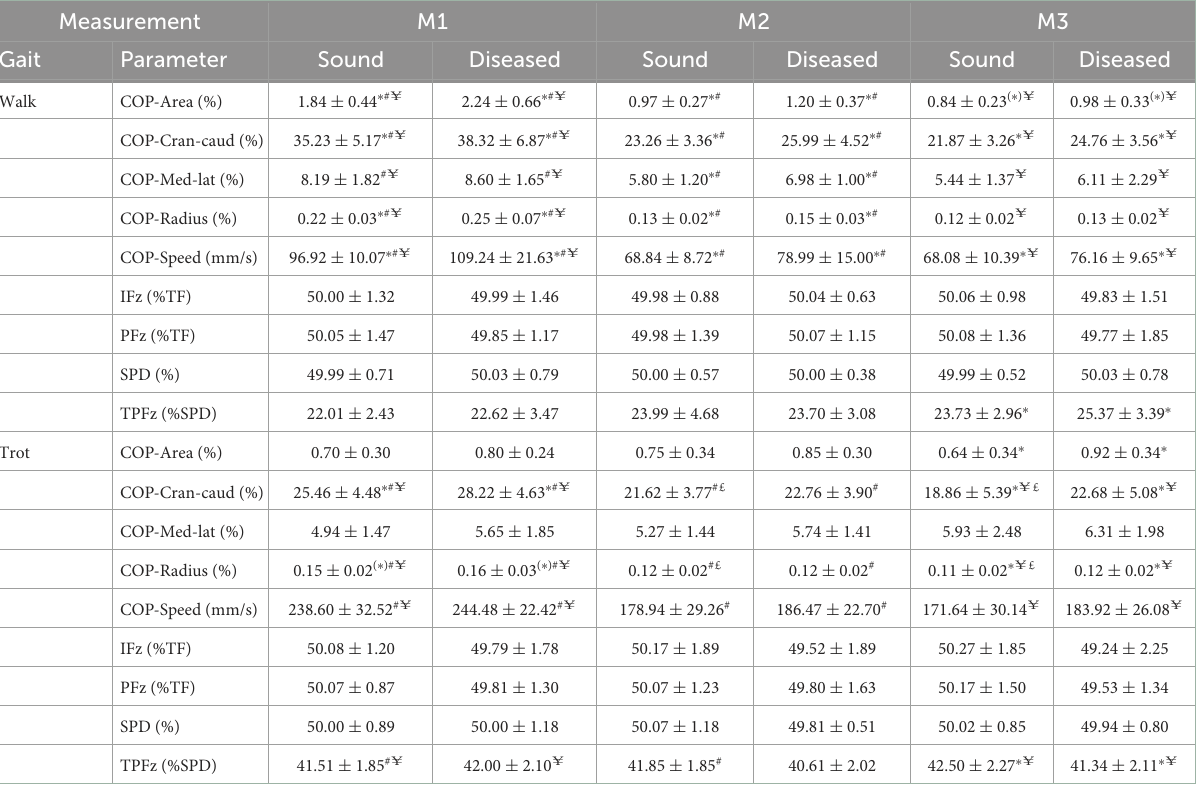
TABLE 3 Descriptive statistics (mean ± SD) for walking and trotting Labrador Retrievers ( n = 32) at three measurement points (M1 = 4 months, M2 = 8 months, and M3 = 12 months of age) in sound and diseased limb groups.